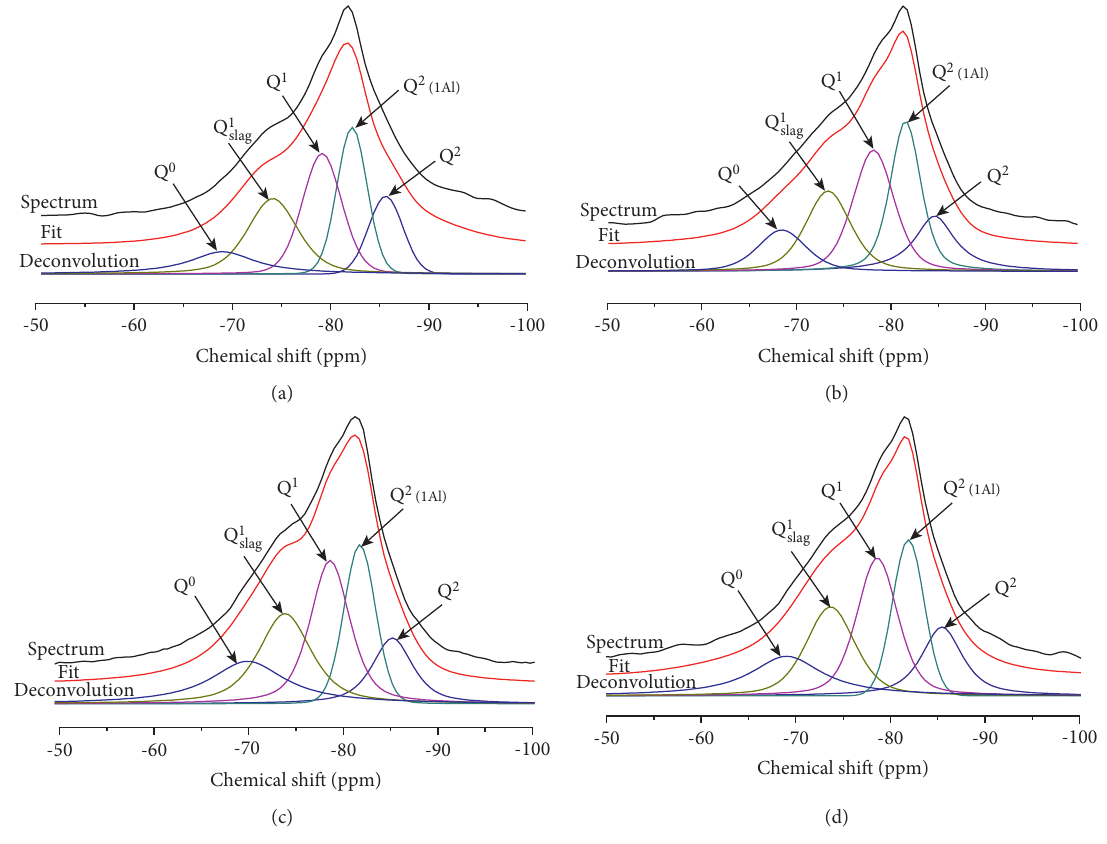
Figure 6: Deconvolution of 29 Si MAS NMR patterns: (a) C0-28d; (b) C0-56 d; (c) C12-28 d; (d) C12-56 d. Table 8: Al/Si ratio of C-(A-)S-H, MCL and α obtained by 29 Si MAS NMR.